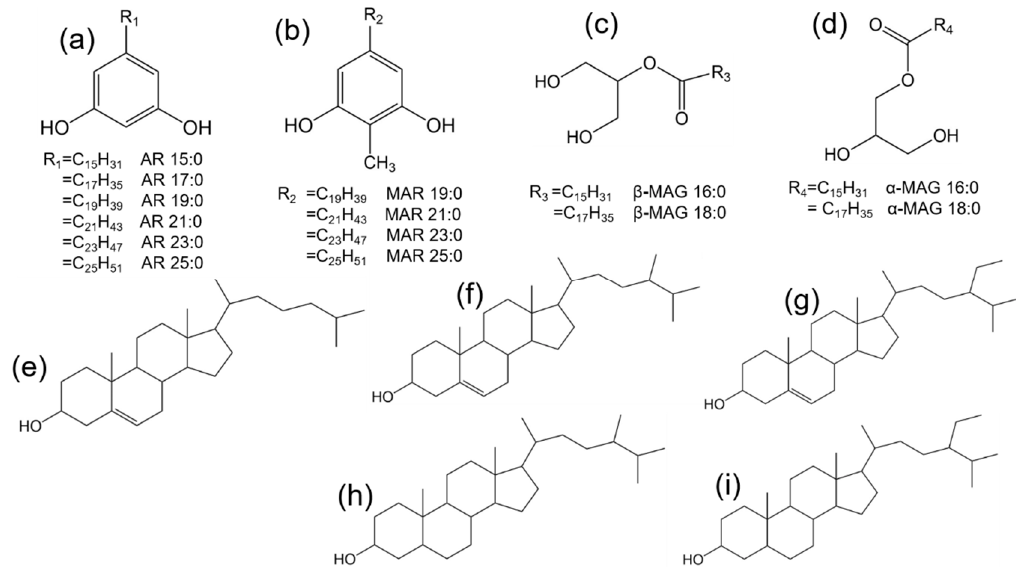
Figure 5. Structures and abbreviations representative of the main compounds identified in the extracts of wheat and referred in the text. ( a ) AR(n); ( b ) MAR(n); ( c ) β -MAG(n); ( d ) α - MAG(n); ( e ), cholesterol; ( f ) campesterol; ( g ) sitosterol; ( h ), campestanol; ( i ) sitostanol. R n are n-alkyl chains.